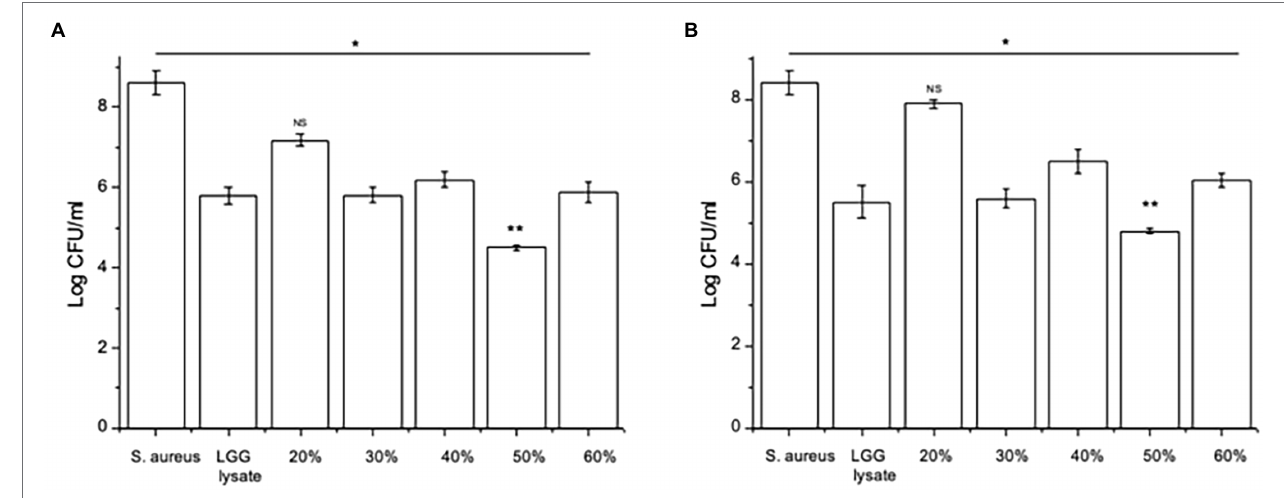
FIGURE 2 | Specific fractions inhibit staphylococcal adhesion to keratinocytes. (A) Keratinocytes pre-treated with L. rhamnosus GG lysate had significantly fewer adherent Staphylococci compared to cells infected with S. aureus alone. The adhesion of the pathogen to keratinocytes was significantly lower in cultures treated with fractions eluting in 30%, 40%, 50% and 60% acetonitrile (* p = 0.01, * p = 0.016, ** p = 0.012, and * p = 0.015, respectively). (B) The same fractions were also efficacious when added to keratinocytes 2 h after incubation with pathogen (* p = 0.034, * p = 0.035, ** p = 0.01, and v p = 0.033 for 30%, 40%, 50%, and 60%, respectively). Data are presented as the mean ± SEM, n = 3. ns = Non- significant. Pre-treatment of keratinocyte monolayers with recombinant TABLE 1 | The Inhibition of Staphylococcus aureus growth by whole and TPI (rTPI; Figure 5A ) and recombinant ENO (rENO; fractionated LGG lysate. Figure 5B ) at 10, 25 or 50 μ g/ml inhibited adhesion S. aureus Treatment to keratinocytes in a dose-dependent manner. Treatment of keratinocyte monolayers with 25 and 50 (but not 10) μ g/mL rTPI ( Figure 5A ) and rENO ( Figure 5B ) for 2 h following